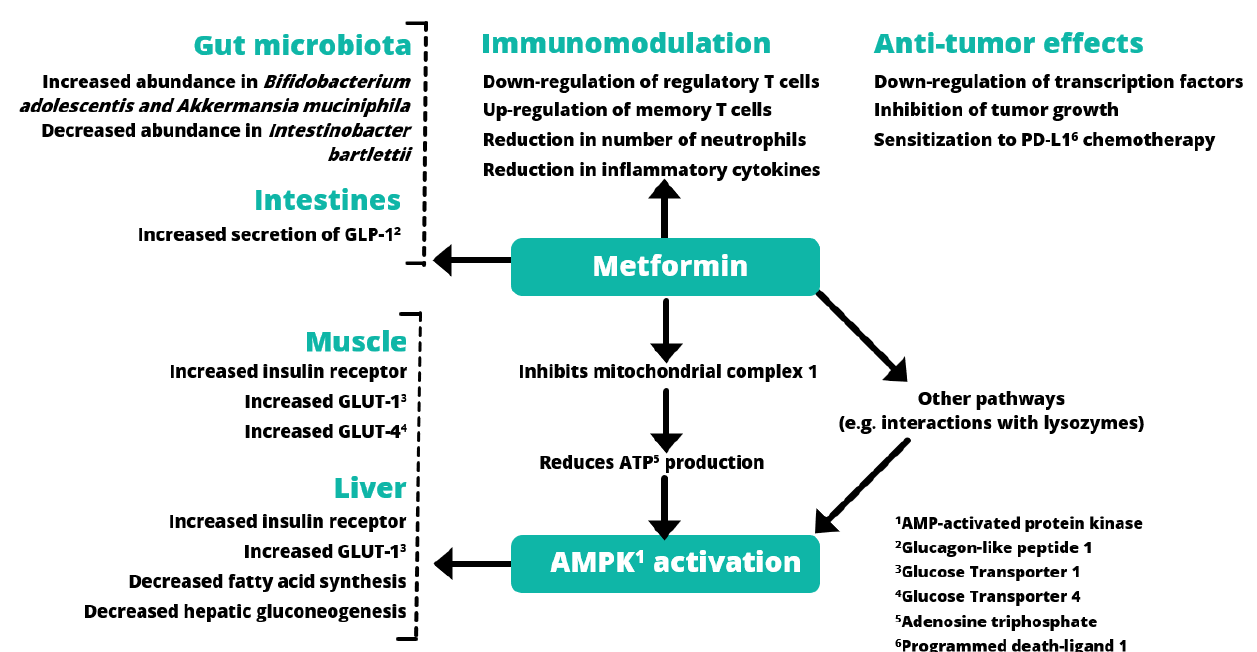
Figure 1. Mechanisms of metformin. The multifaceted nature of the mechanisms of metformin targeting different organs, including liver, muscle, and gastrointestinal tract, including the microbiota, results in glucose-lowering, anti-inflammatory, and anti-cancer effects through AMPK and non-AMPK dependent pathways (adapted from references [16–19]).